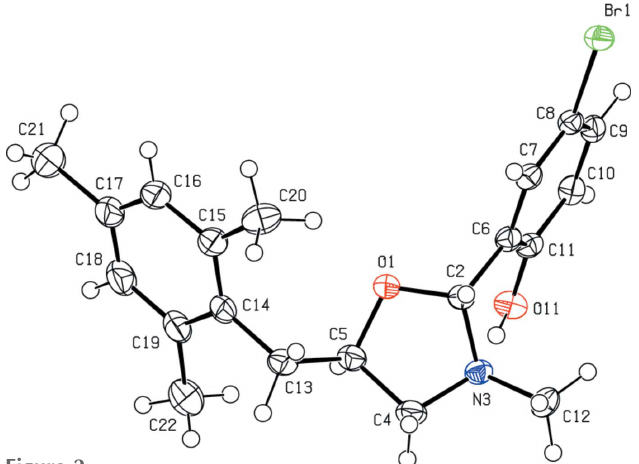
, z + 1 ; (ii) 2 2 , z (cid:5) 1 ; (iv) x , (cid:5) y + 1 , z (cid:5) 3 . 2 2 2 2